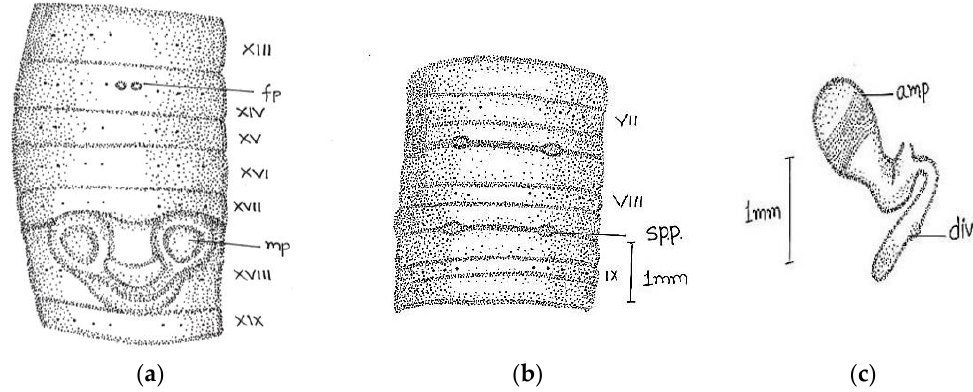
Figure 12. Camera lucida illustration of Megascolex vazhichlensis sp. nov. ( a ) genital region ( b ) sper- mathecal region; ( c ) spermathecae. Table 1. Comparative account of morphological characters of selected Megascolex species which be- long to different clades in phylogenetic trees.